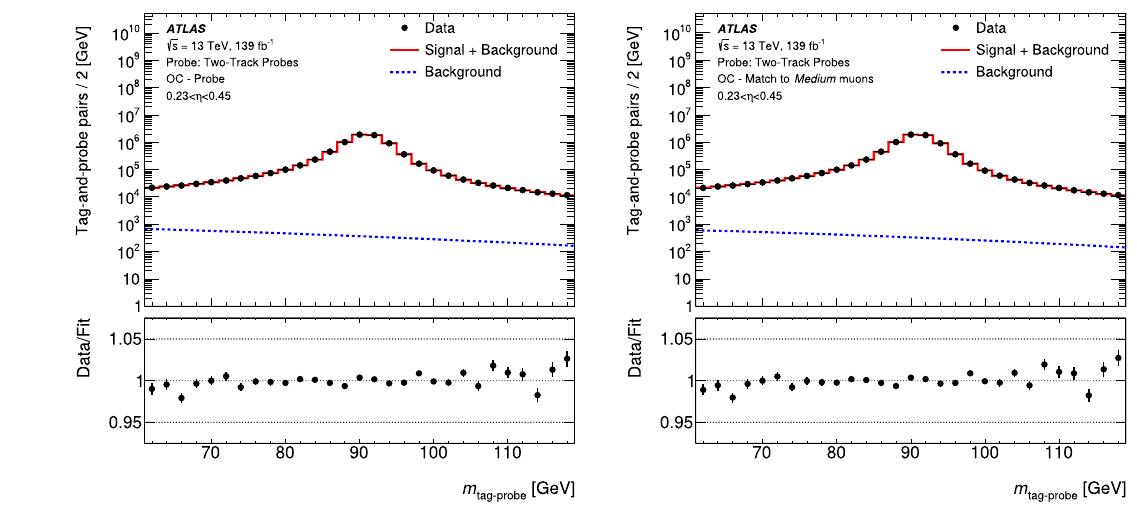
component, while the red line represents the total fitted signal plus the background contribution. The panel beneath shows the data to fit- function ratio for each bin. The error bars indicate the statistical uncer-